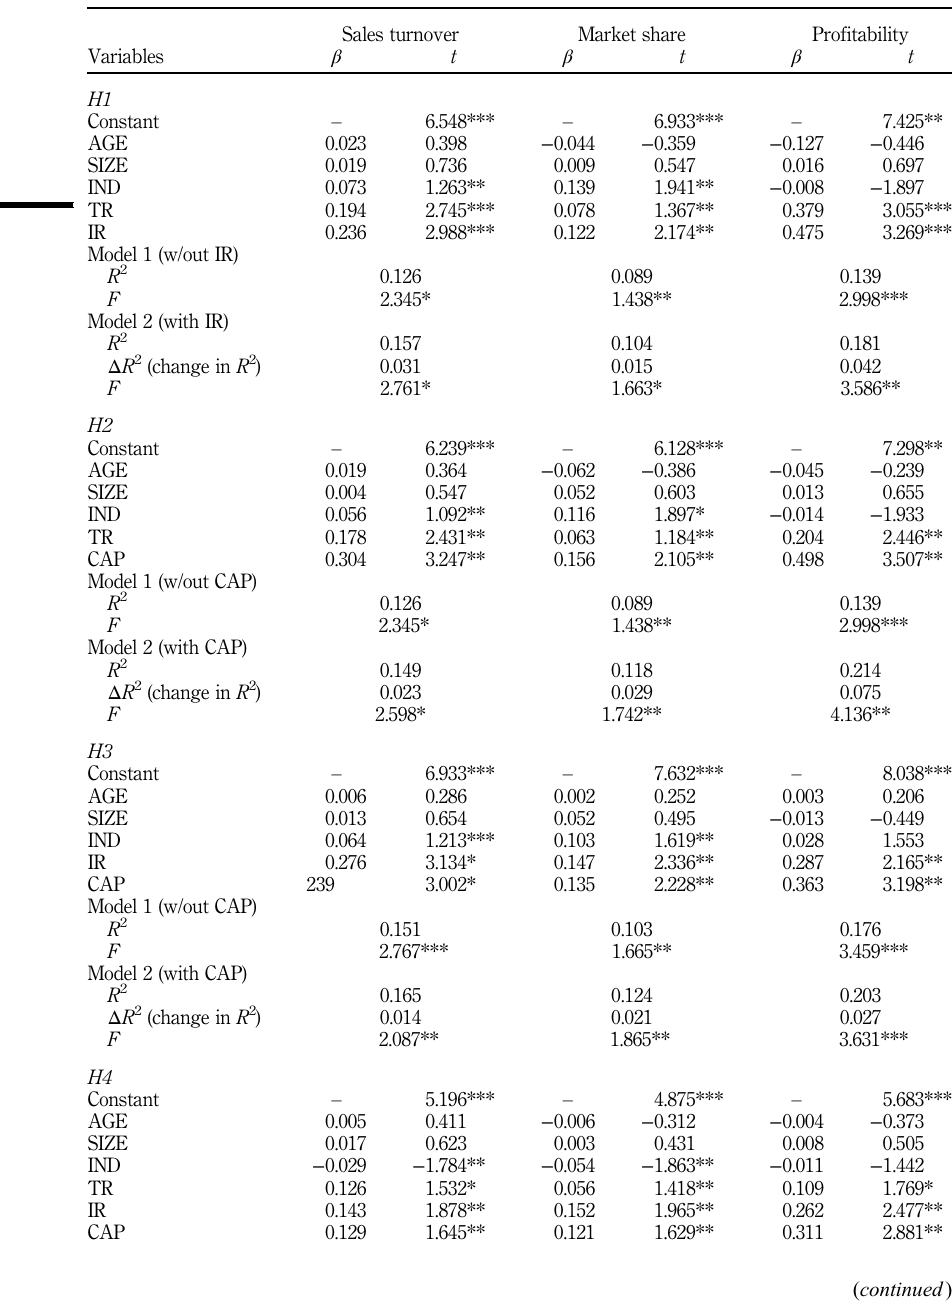
Table VIII. Statistics